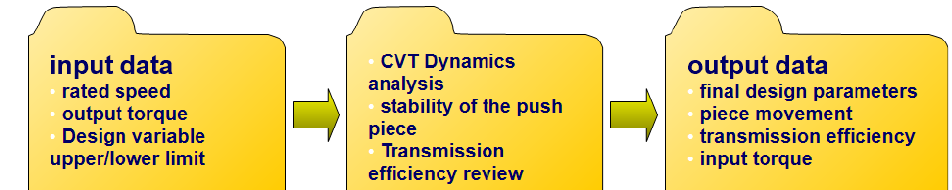
Figure 6. The principle of the design program for improving CVT performance.